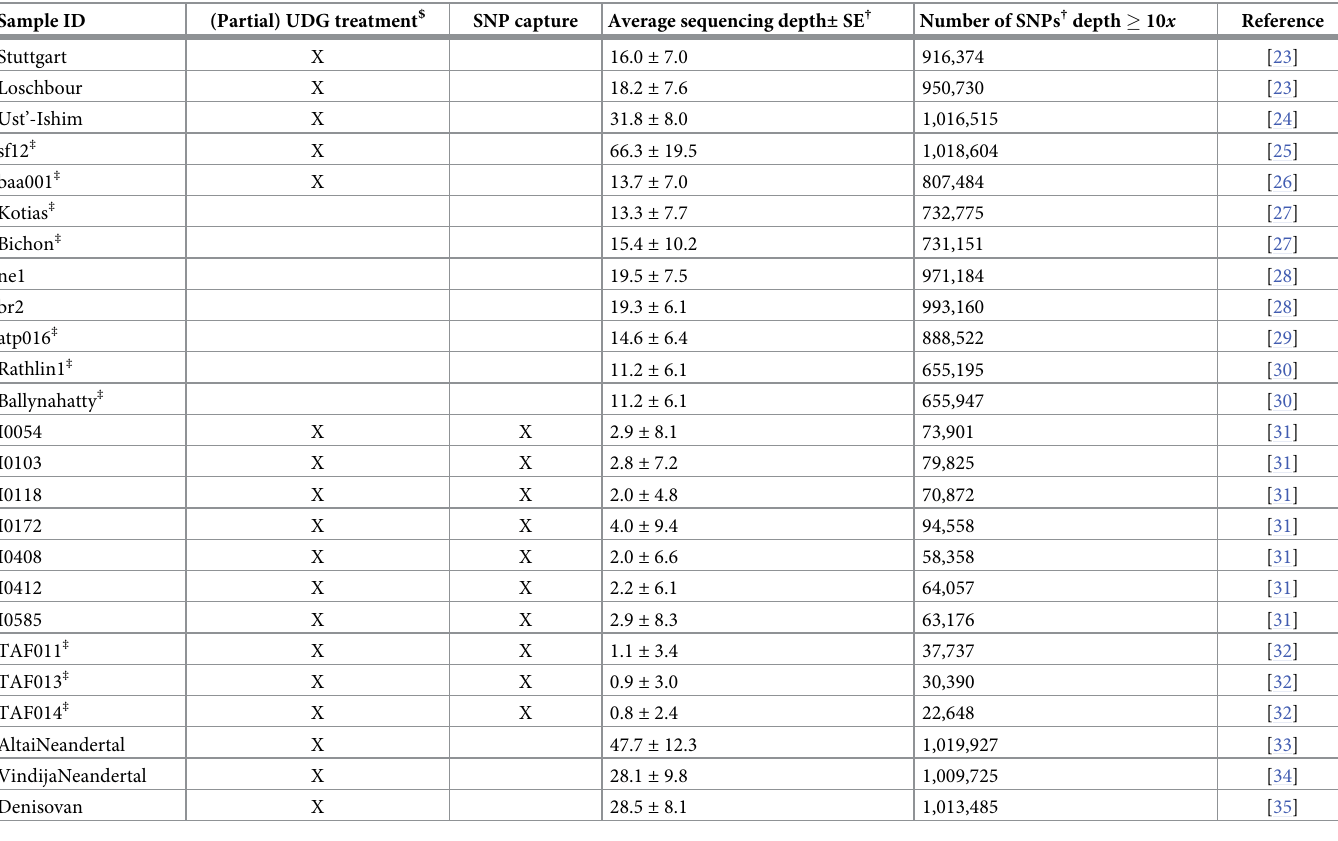
Table 1. Information on the published medium to high coverage palaeogenomic and archaeogenomic data used in this study.